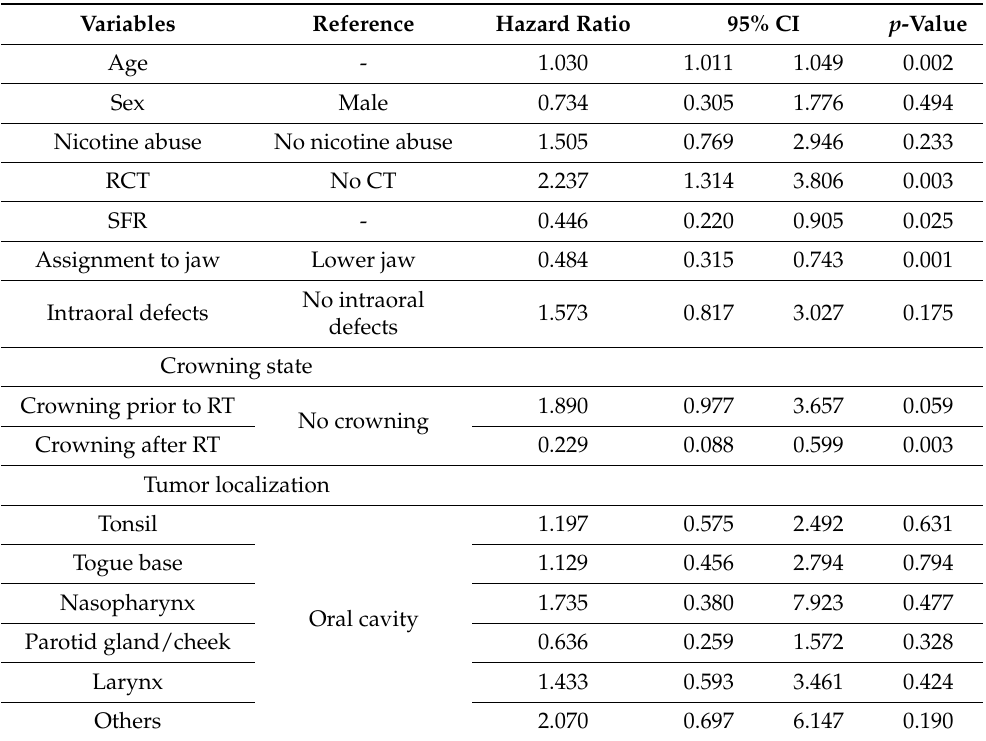
Table 3. Hazard ratios for demographic and clinical characteristics of irradiated patients for survival of